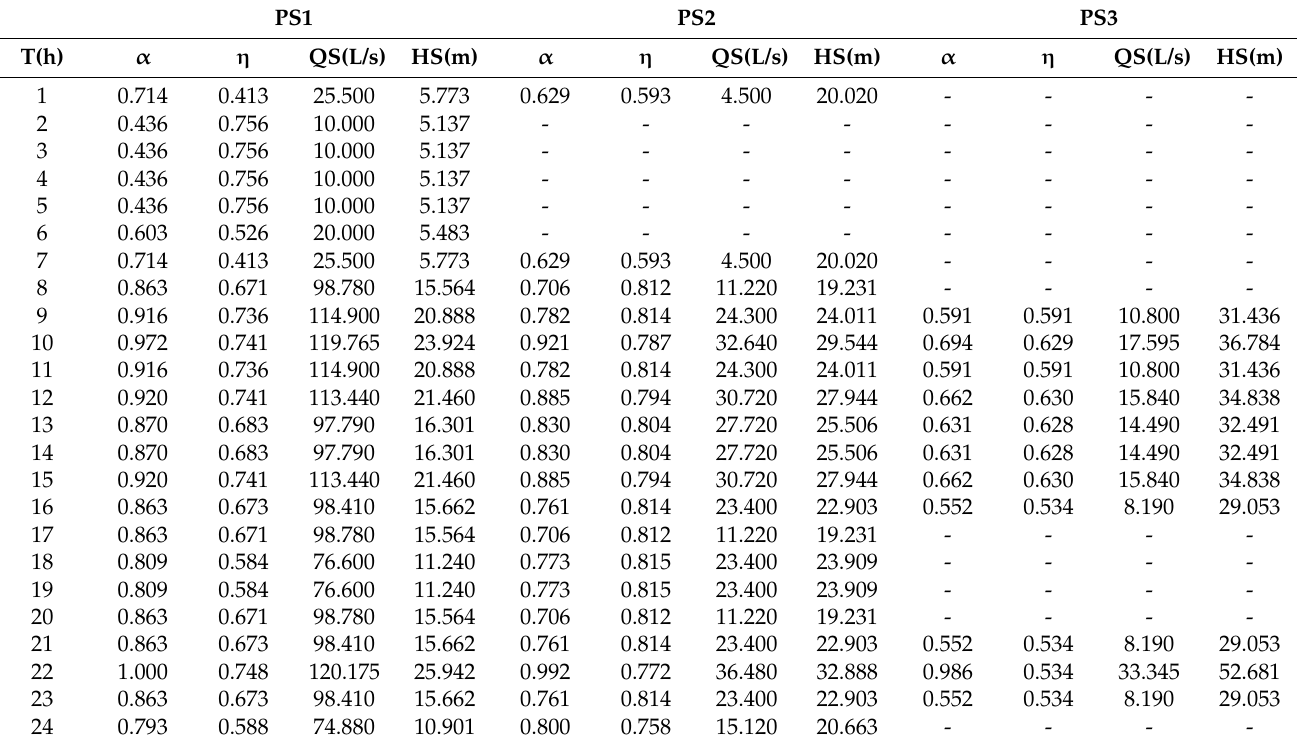
Table 6. PS designs for the case study.